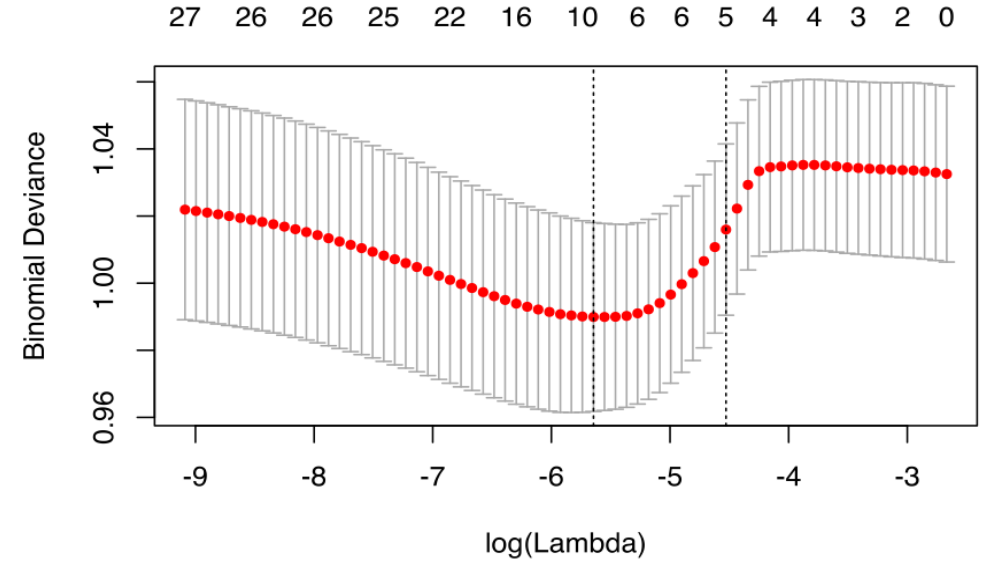
Figure 2. Cross validation plot for the penalty